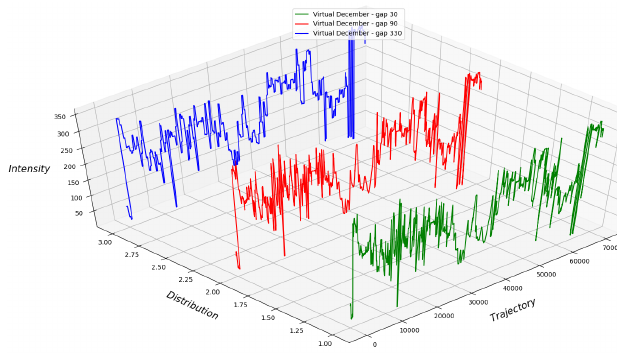
Analyzing the unique light signature function for the trajectory Deva to Bucures ti along the measured , distribution, multiple virtual light signature shapes can be derived as represented in figure 20.